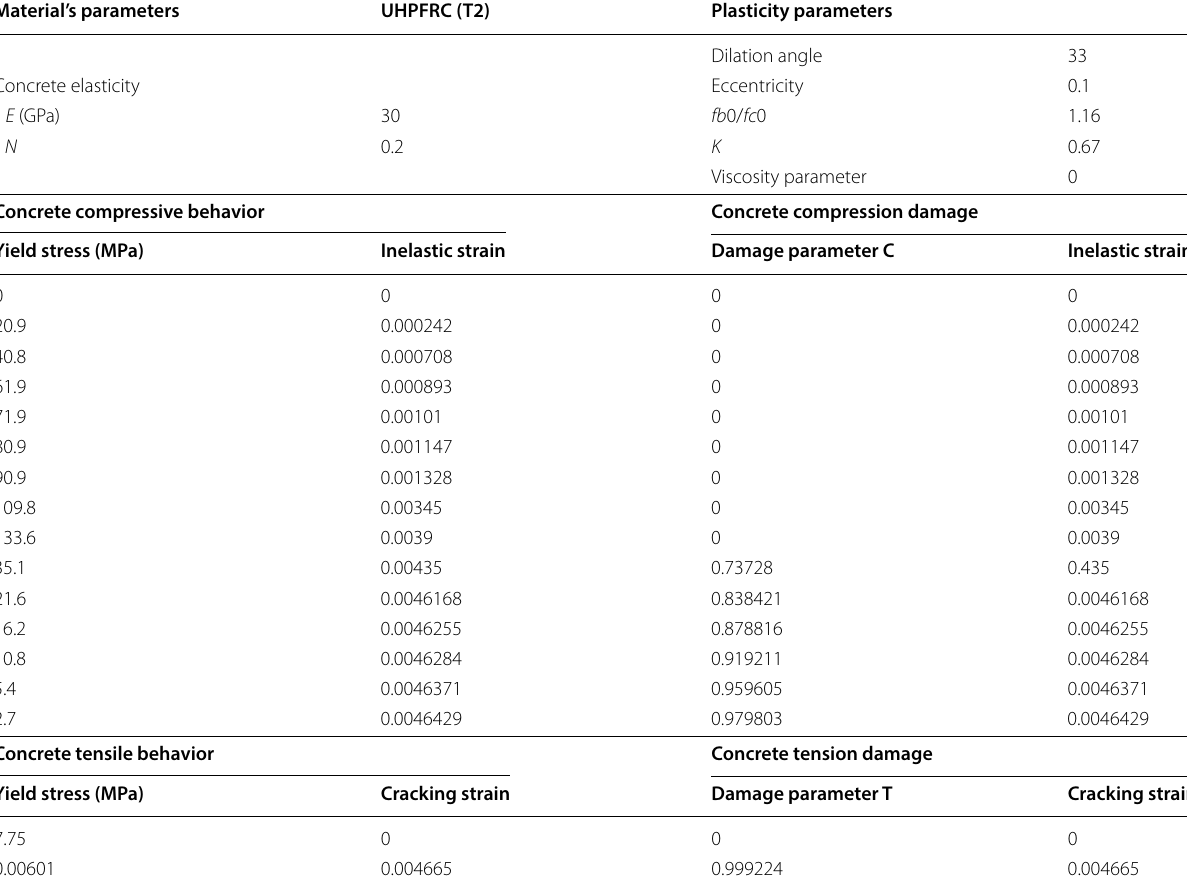
Table 6 Material properties for concrete with developed constitutive model in UHPFRC with 5D steel fibers (T2) Material’s